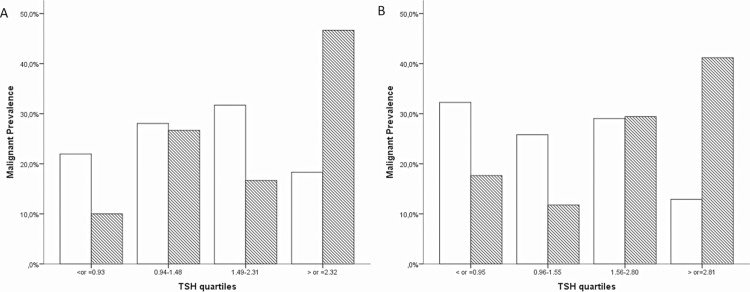
Frequencies of malignant and benign nodules according to TSH quartile.CLIA, Chemiluminescent immunoassay; ECLIA, electrochemiluminscent immunoassay. Frequencies of malignant (dashed bars) and benign (white bars) nodules according to TSH quartile for CLIA(A) and ECLIA (B). A significant increase in the prevalence of malignancy was noted in higher TSH quartiles. P<0.01.